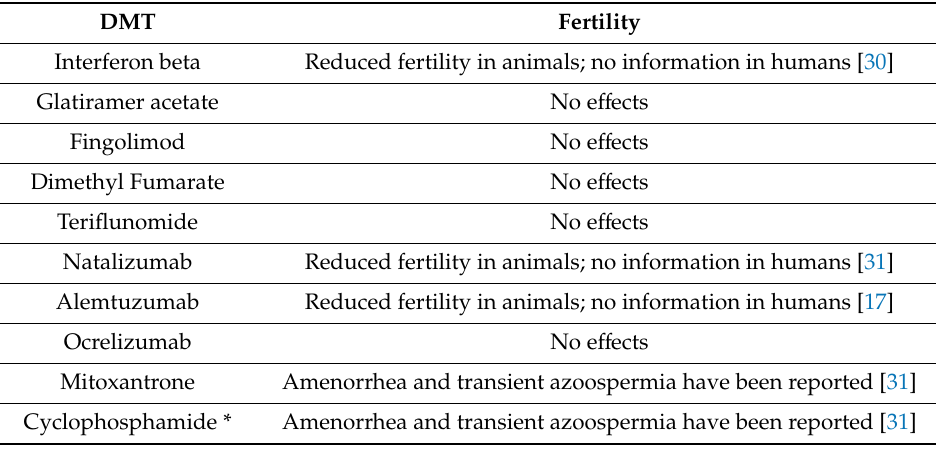
Table 2. Summary of reported MS DMT e ff ects on